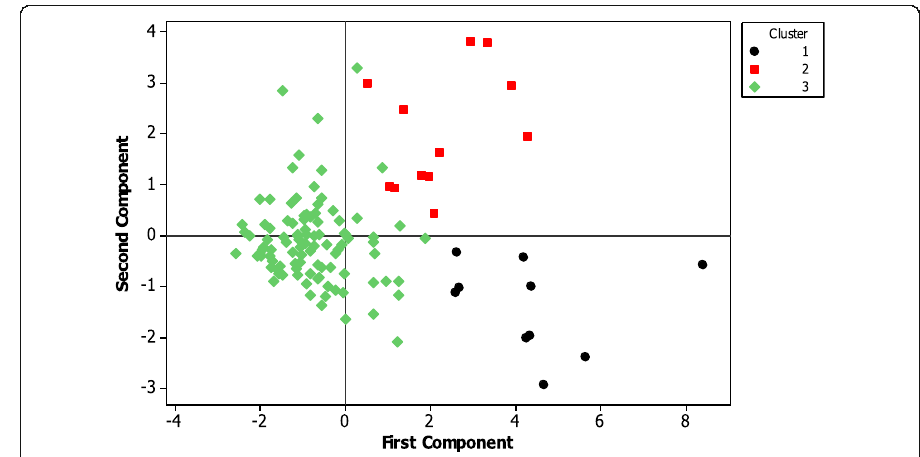
Fig. 3 Score plot for principal components 1 and 2 from PCA. Clusters from the hierarchical ascending classification are shown in black (cluster 1), red (cluster 2), and green (cluster 3)